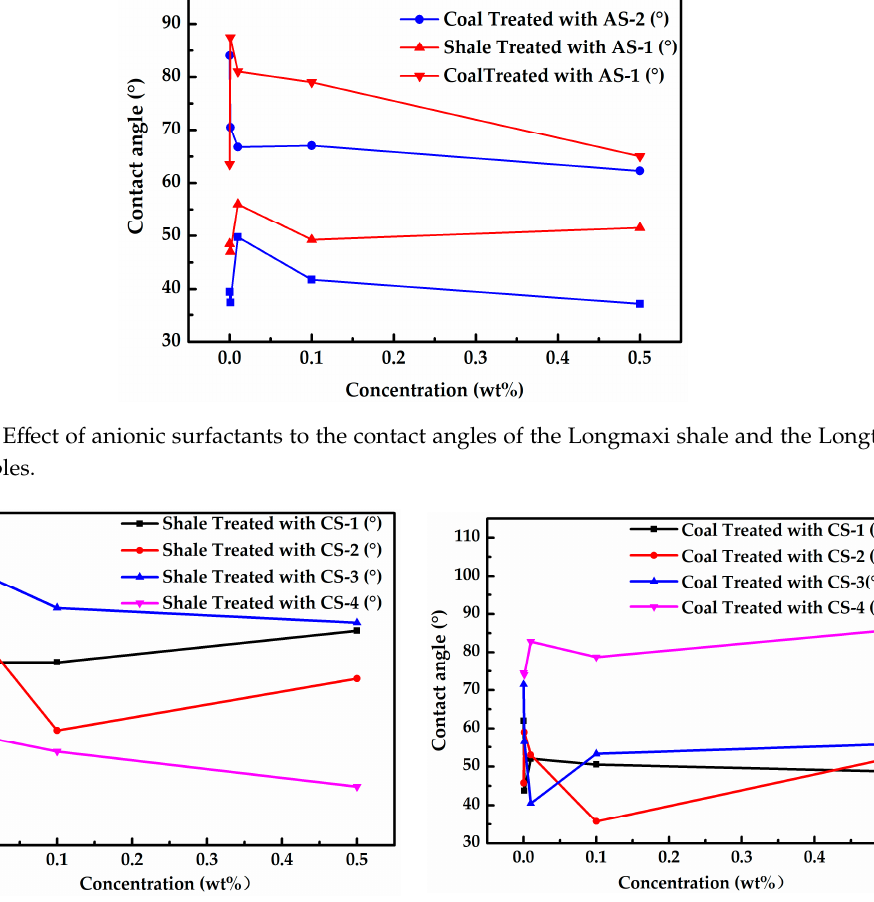
Figure 5. E ff ect of cationic surfactants to the contact angles of the ( a ) Longmaxi shale and ( b ) the Longtan coal samples.